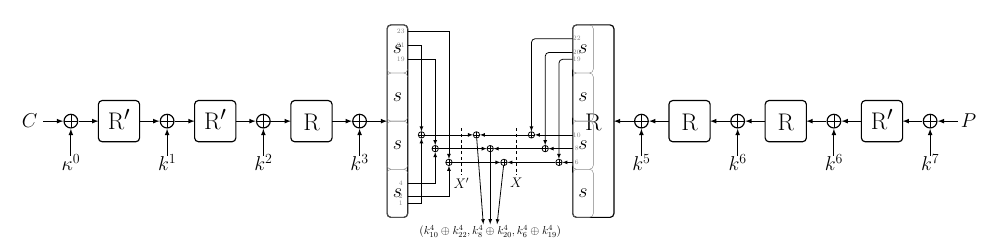
Figure 6: Meet-in-the-middle attack on 8 round version of